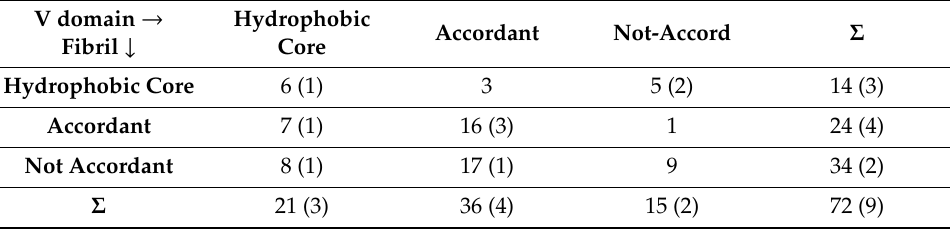
Table 7. Status (number) of residues involved in the construction of the hydrophobic core, showing the status in accordance with the fuzzy oil drop model and incompatible with the fuzzy oil drop model. The columns express the status in the V domain, the status in rows as it is observed in the fibrillar form. Only fragments 2–37 and 66–105 in domain V were analyzed. The numbers in parentheses give the number of residues with di ff erent levels of intrinsic